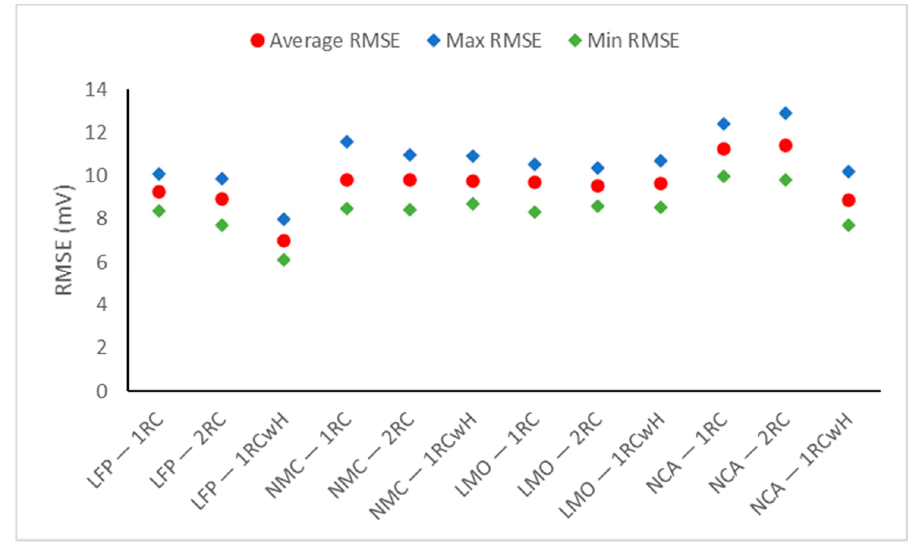
Figure 8. Model validation performance of different equivalent circuit models for various lithium-ion cell chemistries under the UDDS cycles.